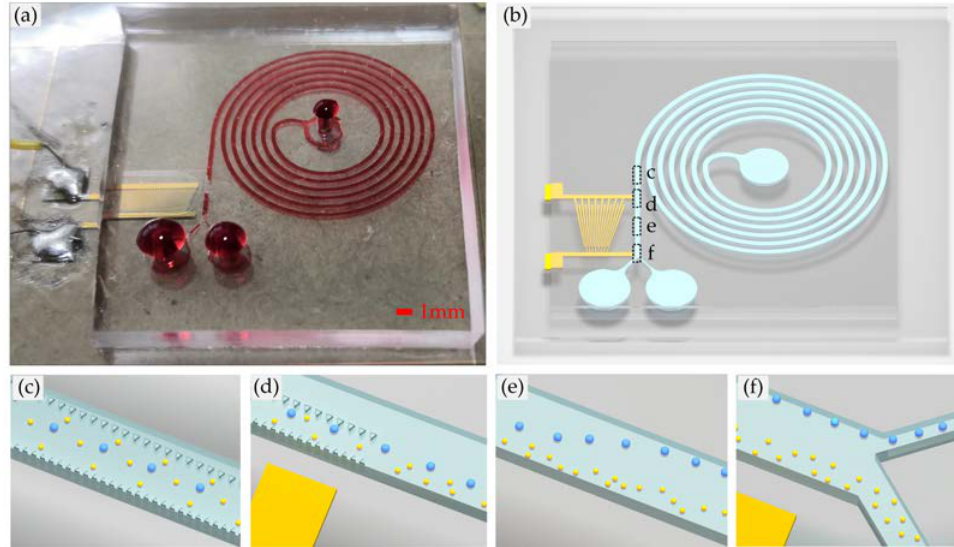
Figure 1. ( a ) Physical picture of the sorting chip; ( b ) Overall schematic diagram of the sorting chip; ( c ) The large particles are arranged in a line and the small particles are randomly scattered throughout the flow channel at the beginning of contact with the micropillar array; ( d ) All particles converge in the area 150 μm away from the outer wall of the flow channel when leaving the micropillar array region; ( e ) The large particles are deflected by acoustic control, while the small particles keep their original trajectory and continue to move forward; ( f ) Particles of different sizes are discharged from their respective outlets.